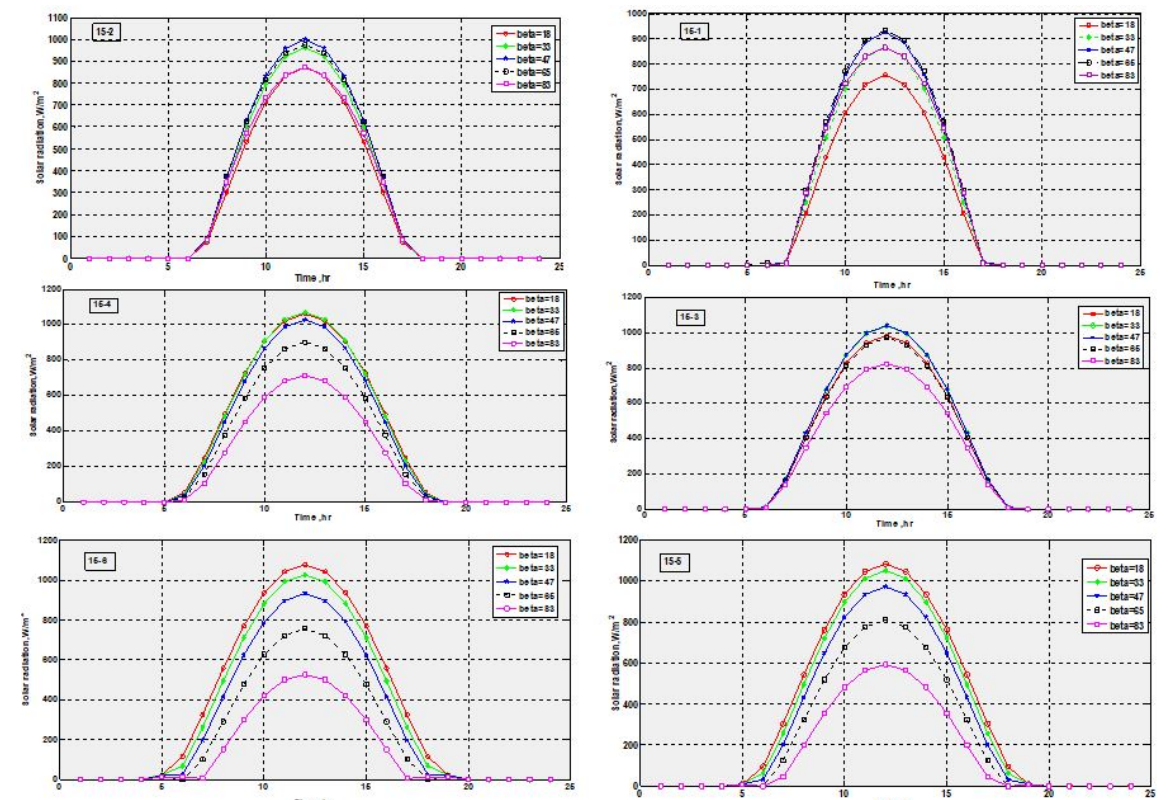
Figure 6. Comparison between numerical and experimental results of the estimated solar